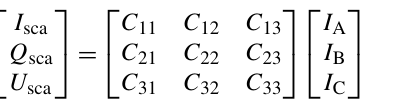
Figure 1. (a) Cross-section image of the AirHARP instrument ren- dered using CAD software; (b) AirHARP instrument mounted on the ER-2 aircraft left-wing front pod (image courtesy of Brent McBride); (c) image captured by NASA Science Pilot D. Stuart Broce during the ACEPOL flight on 26 October 2017. The red arrow in the figure points to the AirHARP’s exposed part when mounted on the wing pod. Table 1. Information on AirHARP spectral bands, viewing angles, and measured parameters. Band nominal No. of viewing Measured angles